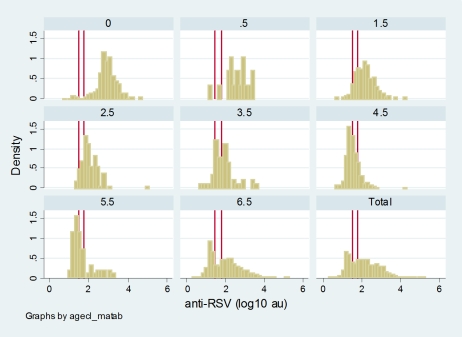
Frequency distribution of antibody titres (log10 AU) by age class (months).Cut-off between seropositive and seronegative is shown by red lines and lies between 1.5–1.8 (log10AU).